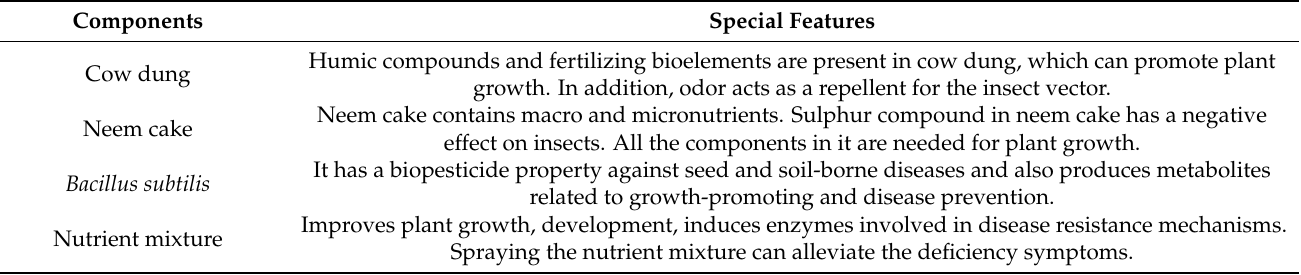
Table 1. The components of combined nutrient/biocontrol agent mixture and its special features. Components Special Features Cow